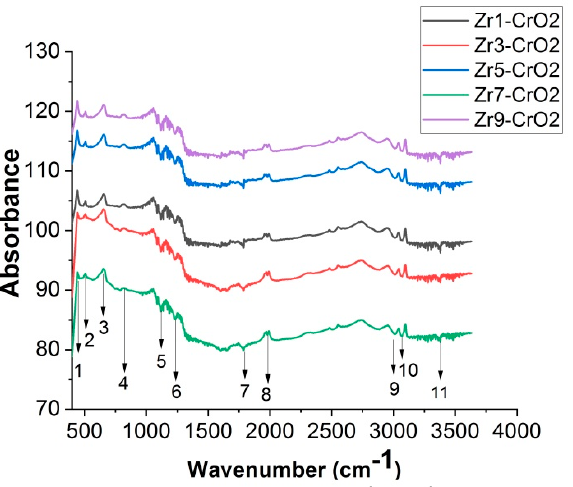
Figure 4. The FT-IR spectra of Zr-doped CrO 2 Figure 4. The FT ‐ IR spectra of Zr ‐ doped CrO 2 photocatalysts. Table 1. FT ‐ IR studies of Zr ‐ doped CrO 2 photocatalysts. Peak Number Functional Group